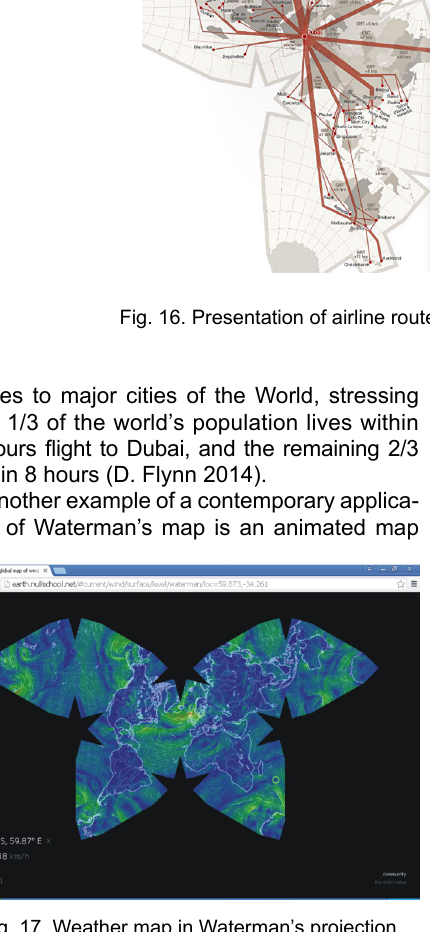
Fig. 17. Weather map in Waterman’s projection (source: Nullschol.net